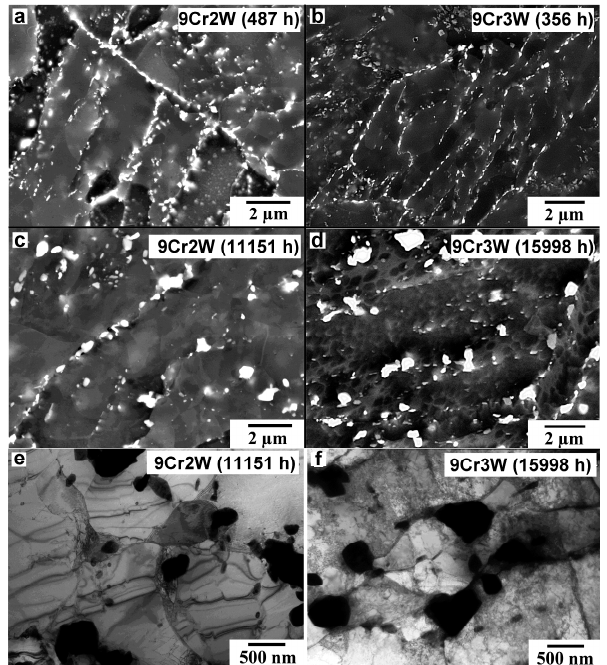
Figure 5. Microstructure of the 9Cr2W ( a , c , e ) and 9Cr3W ( b , d , f ) steels after creep rupture tests at 650 ◦ C under the stress of: ( a ) 160 MPa, 487 h; ( b ) 180 MPa, 356 h; ( c , e ) 100 MPa, 11,151 h; ( d , f )